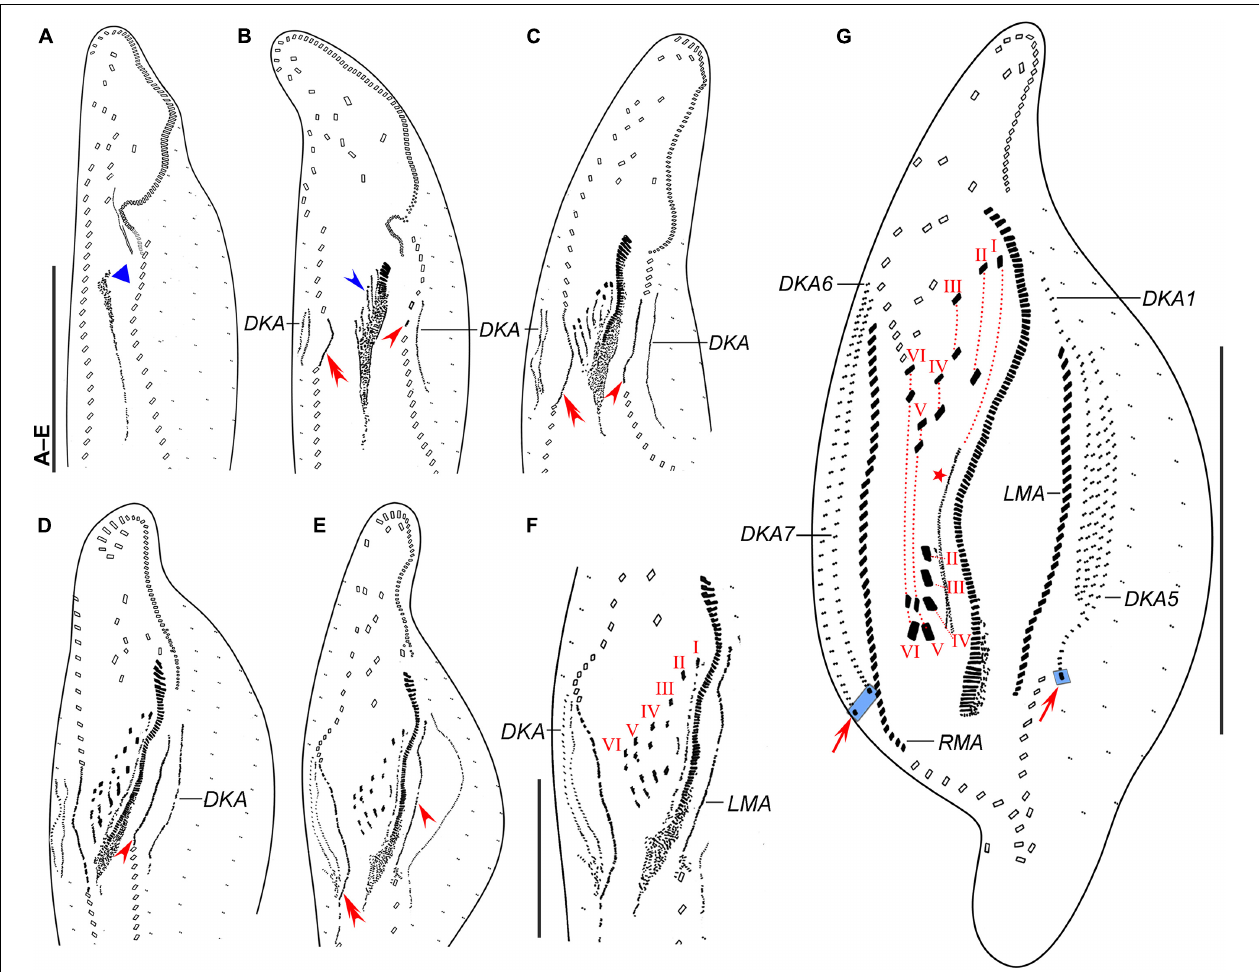
FIGURE 4 | Trachelostyla multinucleata spec. nov., early (A,B) , middle (C–F) , and late (G) stages of physiological reorganization after protargol impregnation. (A,B) Ventral views to show the formation of the oral primordium (blue triangle), frontal-ventral-transverse cirral anlagen (blue arrowhead), right (red double-arrowhead) and left (red arrowhead) marginal cirral anlagen. (C–E) Ventral views, showing the formation of right (red double-arrowheads) and left (red arrowheads) marginal cirral anlagen and dorsal kineties anlagen. (F) Detail, showing the splitting pattern of frontal-ventral-transverse cirral anlagen I–VI. (G) Ventral view to show the formation of marginal cirral rows, caudal cirri (red arrows), dorsal kineties, and undulating membranes (red asterisk). Frontal-ventral-transverse cirri originating from the same anlagen are connected by red dotted lines numbered from left to right with I–VI. DKA1, 5, 6, 7, the first, fifth, sixth, and seventh dorsal kinety anlage; LMA, left marginal cirral anlage; RMA, right marginal cirral anlage; I–VI, frontal-ventral-transverse cirri originating from anlagen I–VI. Scale bars = 50 µ m (F) and 120 µ m (A–E,G)